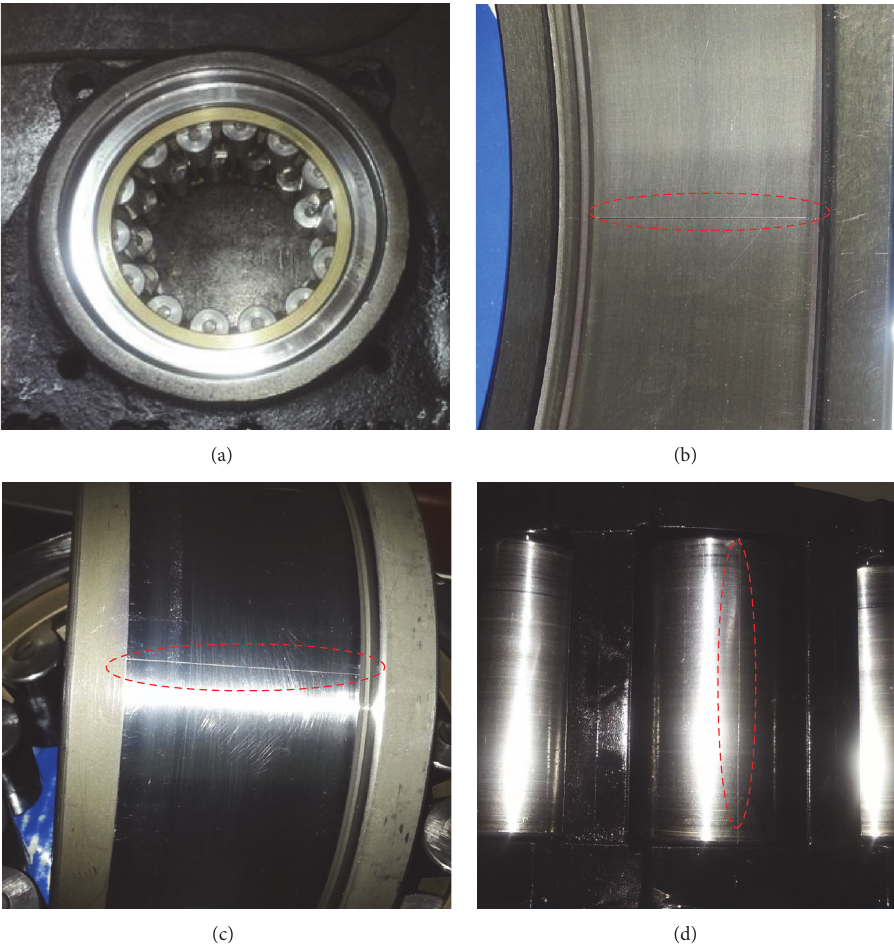
Figure 6: Artificial defects on the components of the axle box bearing: (a) axle box bearing; (b) defect on the outer race; (c) defect on the inner race; (d) defect on the rollers.